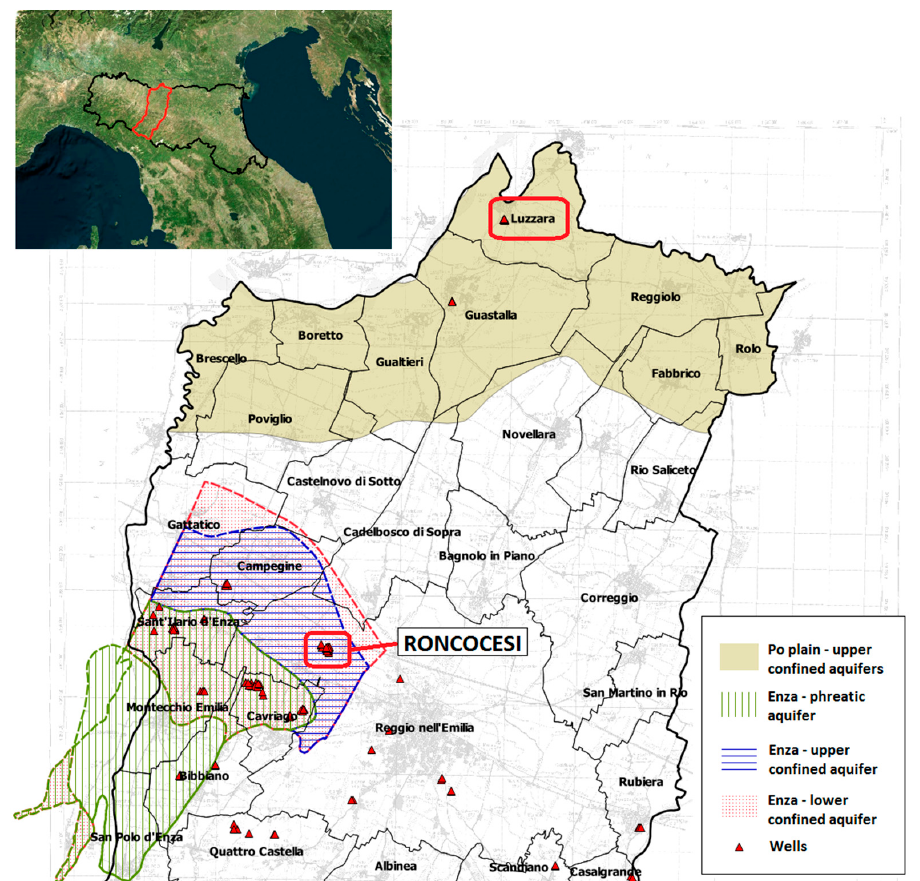
Figure 1. Location of Reggio Emilia Province, hydrogeological units of the Enza and Po rivers, and main well fields.